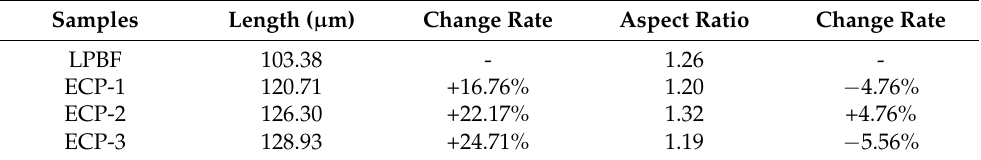
Figure 4. OM micrographs of the LPBF-Ti64 samples before and after ECP treatment: ( a ) LPBF, ( b ) ECP-1, ( c ) ECP-2 and ( d ) ECP-3. Table 5. The length, the aspect ratio and the corresponding change rate of the prior β grains in the LPBF-Ti64 samples before and after ECP treatment.